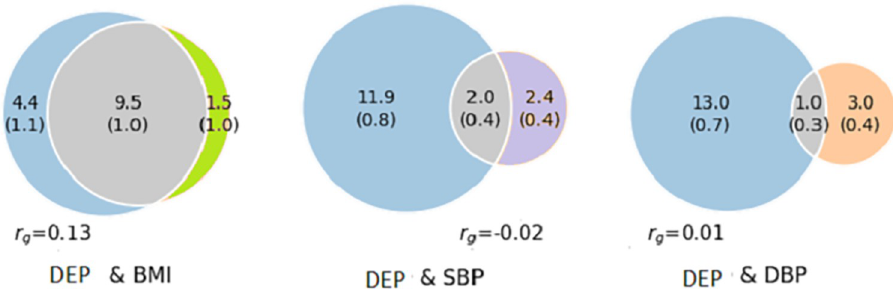
Fig 1. Venn diagrams of causal shared and unique variants. The polygenic overlap between a) depression (blue) and BMI (green) b) depression (blue) and SBP (purple) and c) depression (blue) and DBP (orange). The numbers is the quantity of causal variants with standard errors in parentheses (numbers in thousand). DEP; depression, BMI; body mass index, SBP; systolic blood pressure, DBP; diastolic blood pressure, r g; genetic correlation.